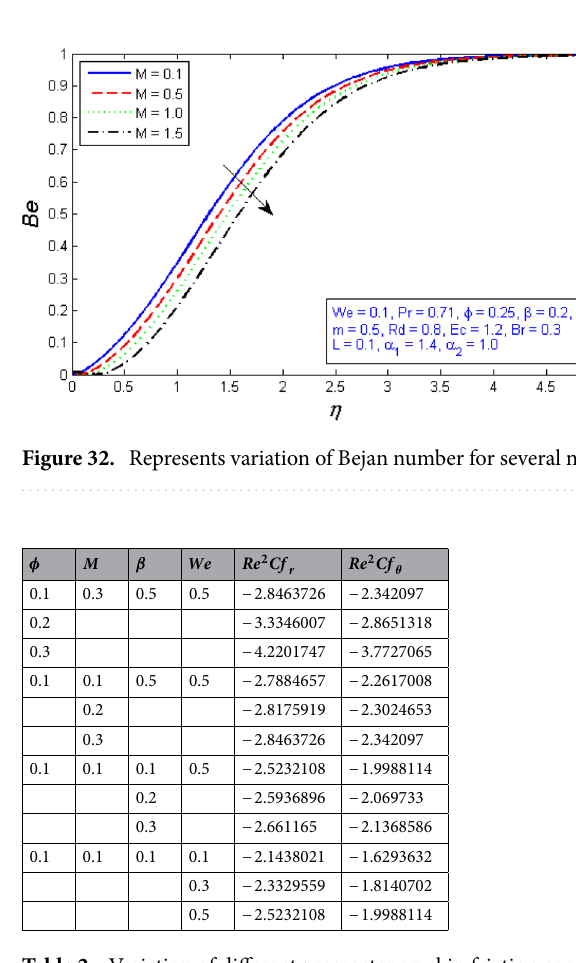
Figure 31. Variation of Entropy generation for several number of magnetic parameter M .